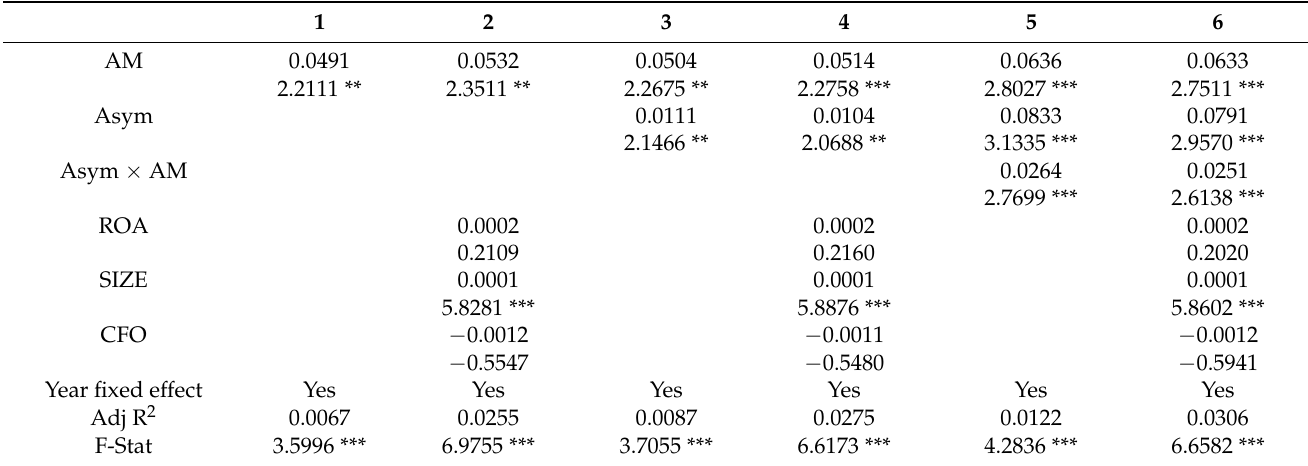
Table 5. The Impact of Positive Accrual Management on Firm-Specific Risk.